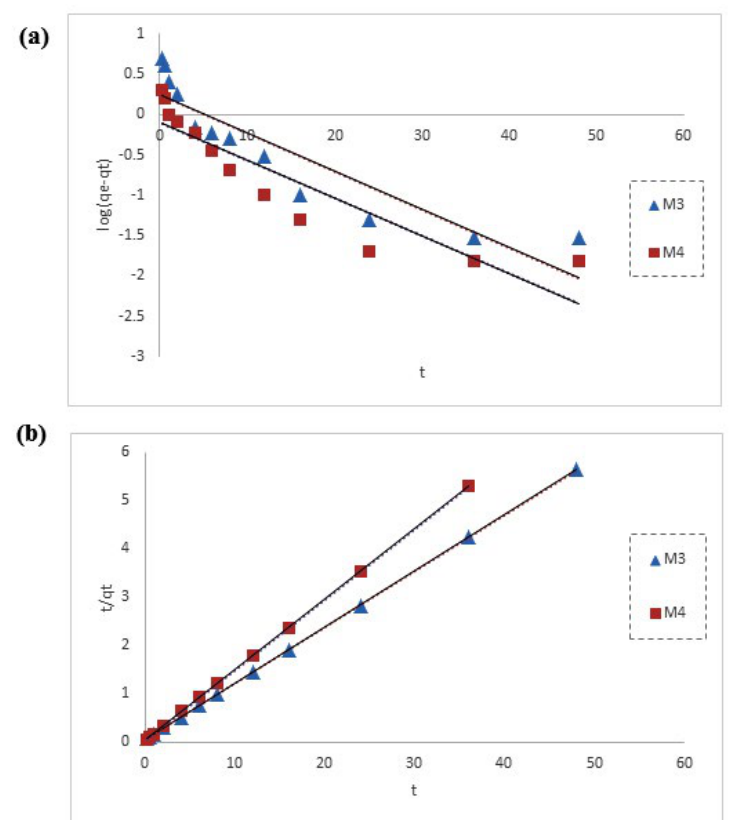
Fig. 6. Kinetic modeling of HA adsorption onto M3 and M4 membranes at pH = 7.0, m = 1 g/L, C adsorption kinetic model, (b), pseudo-second order adsorption kinetic